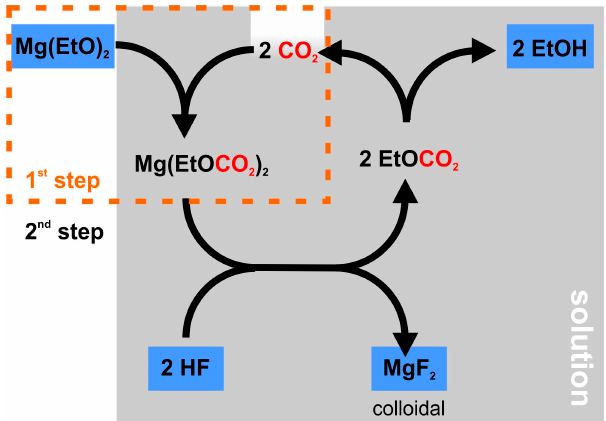
Figure 4. Reaction scheme of the fluorolytic synthesis of colloidal MgF 2 from Mg(OEt) 2 using CO 2 to form a soluble intermediate magnesiumethyl-carbonate species Mg(EtOCO 2 ) 2 [44].